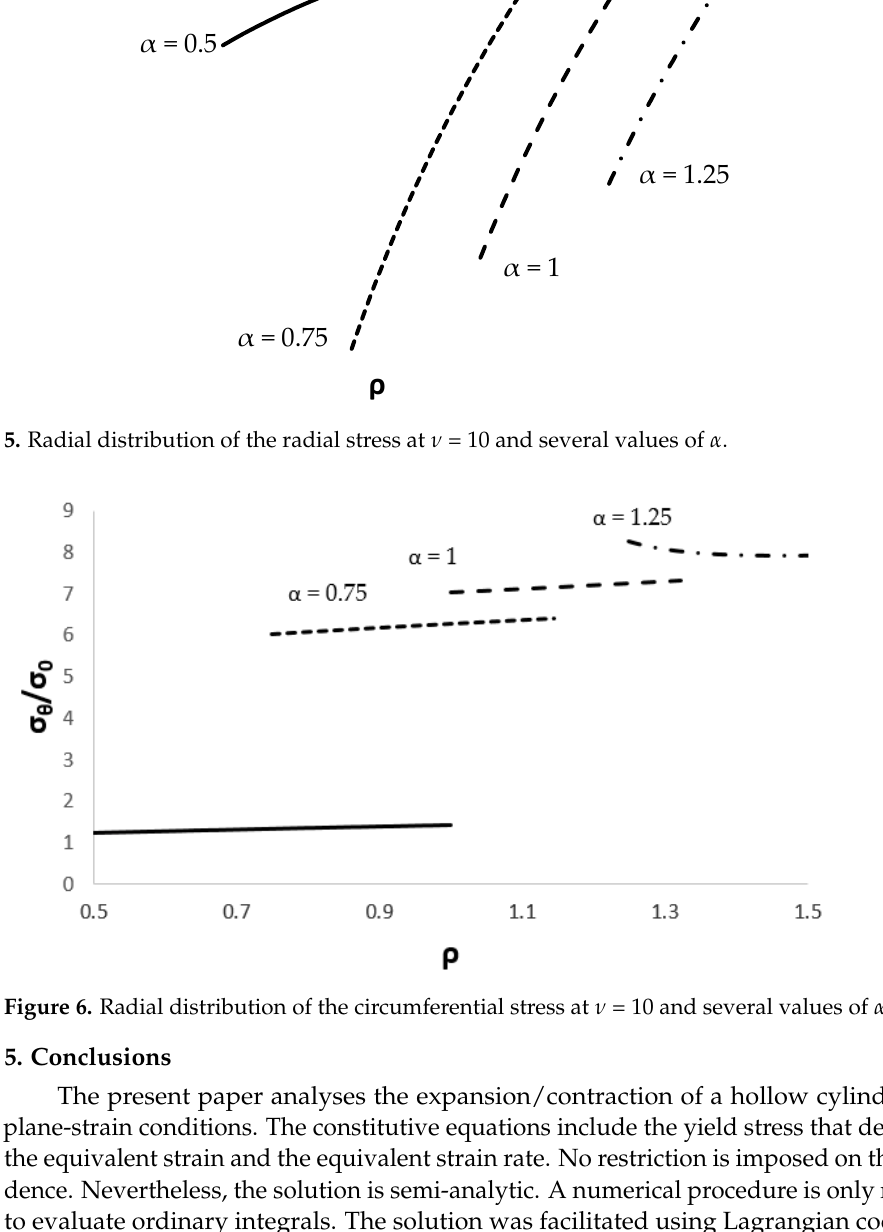
Figure 4. Radial distribution of the circumferential stress at α = 1 and several values of ν .